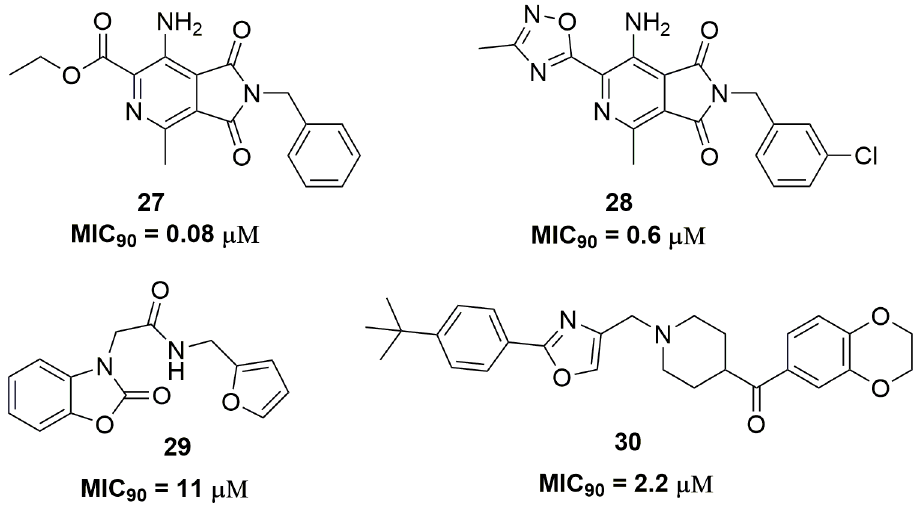
Figure 10. Heterocyclic compounds as promising agents for the treatment of MDR-TB.